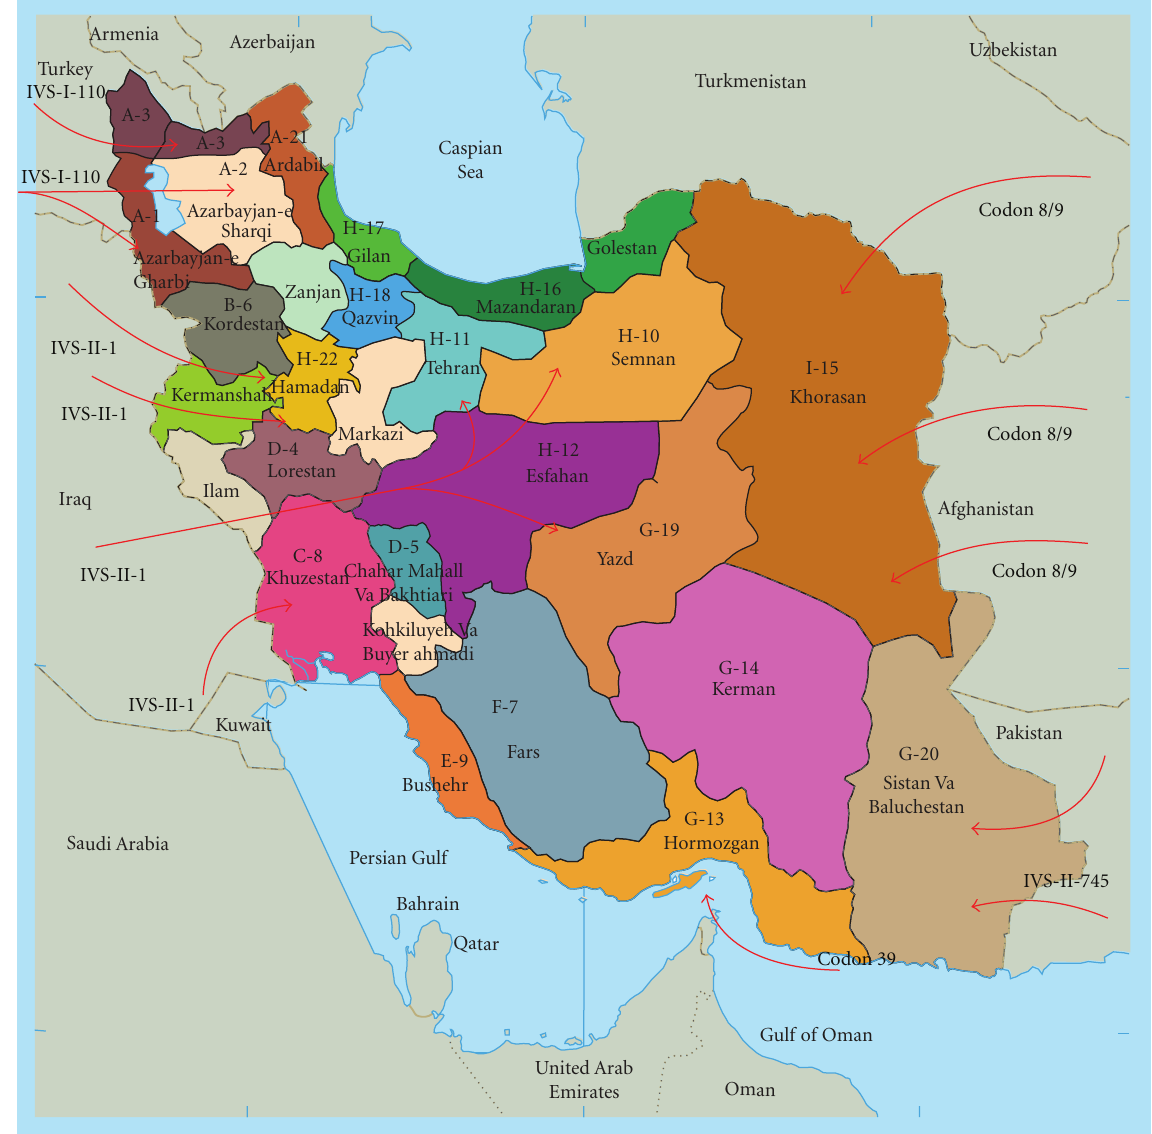
Figure 1: Distribution pattern of di ff erent mutations of β -Thalassemia in 21 provinces of